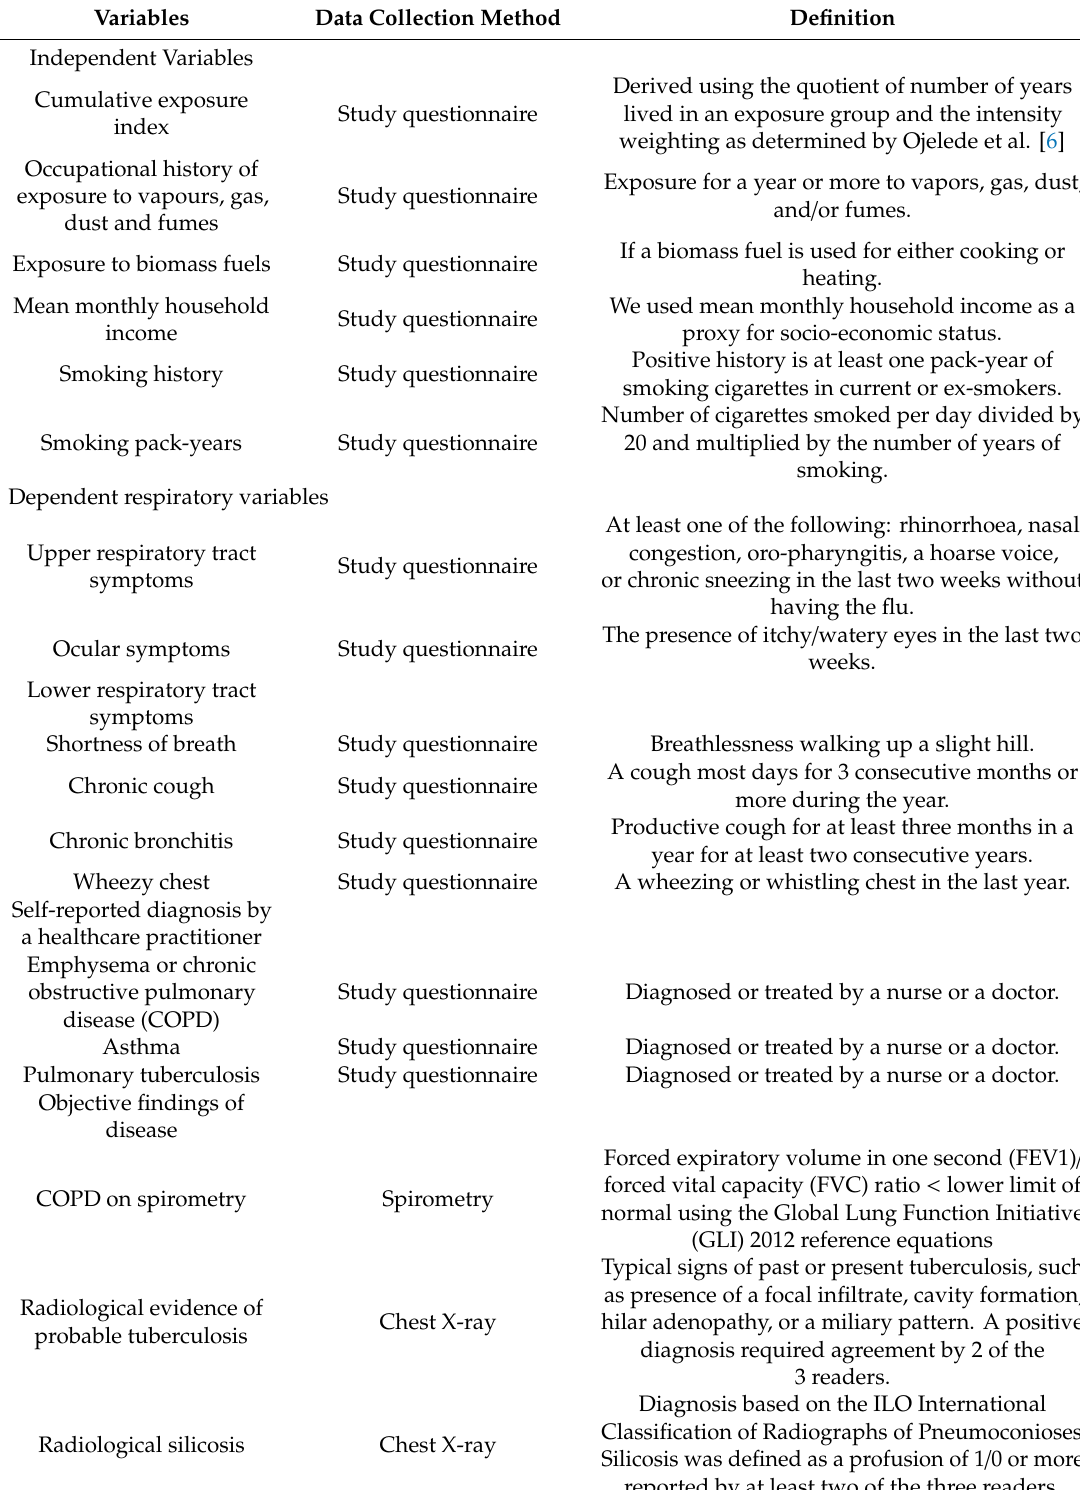
Table 1. The definitions and data collection methods for the outcomes of